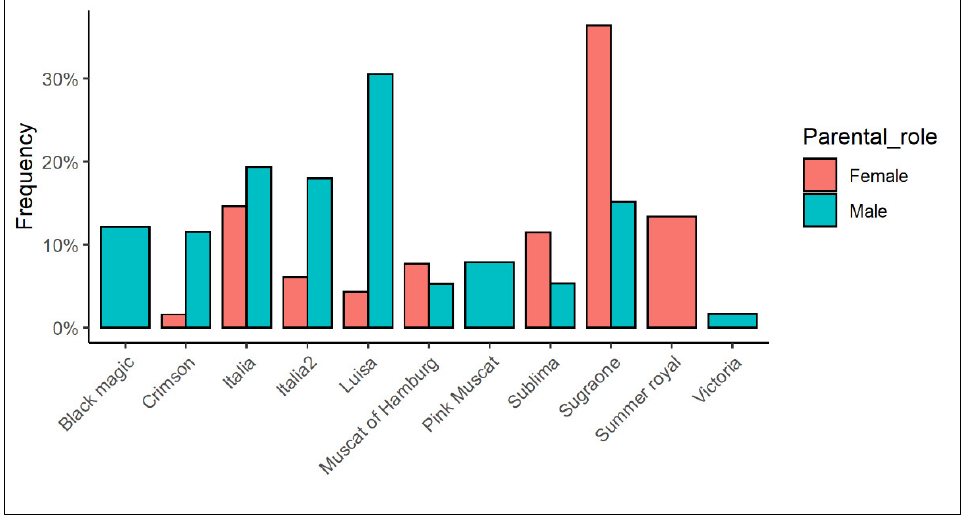
Figure 3. Parental efficiency of each cultivar measured as number of plantlets per embryos/seeds along with all cross combination.